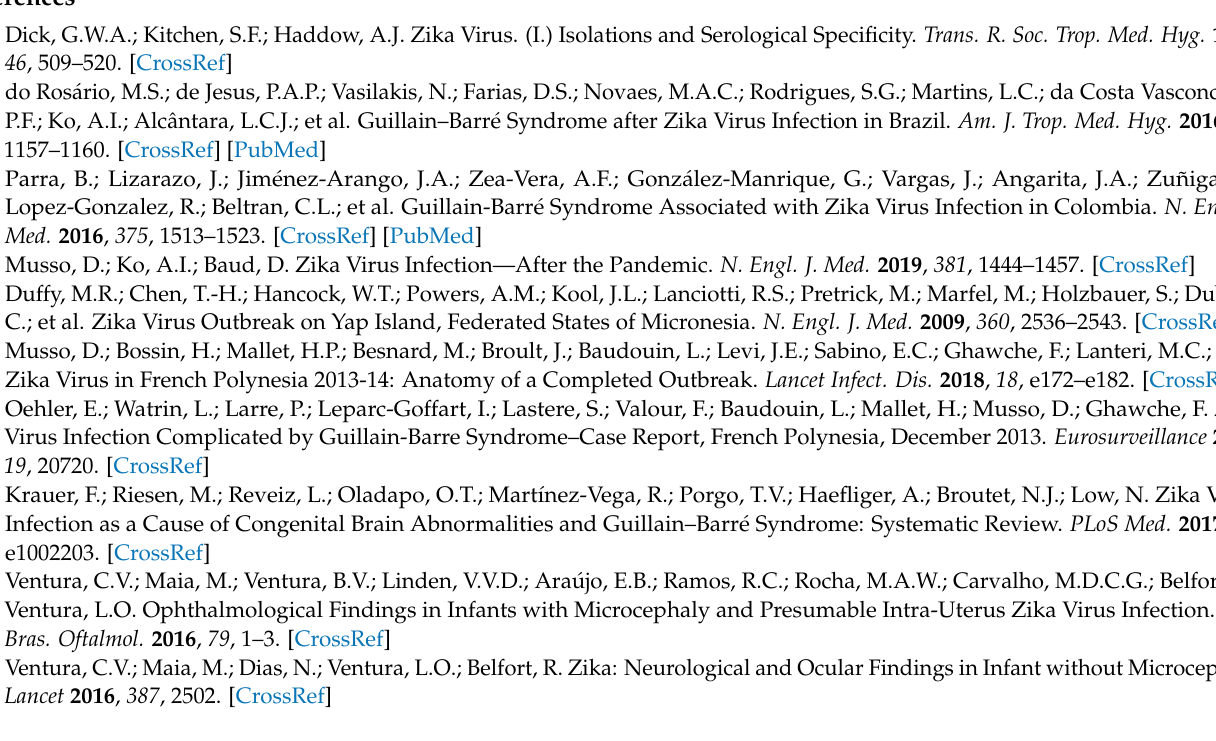
lymphocytes; Figure S2: Changes in body weight of monkeys; Figure S3: Phylogenetic analysis of the ZIKV E protein; Figure S4: Neutralizing activity against heterologous ZIKV strains; Figure S5: IgG had a limited neutralizing activity; Table S1: Number of amino acid substitutions per site among the 24 ZIKV